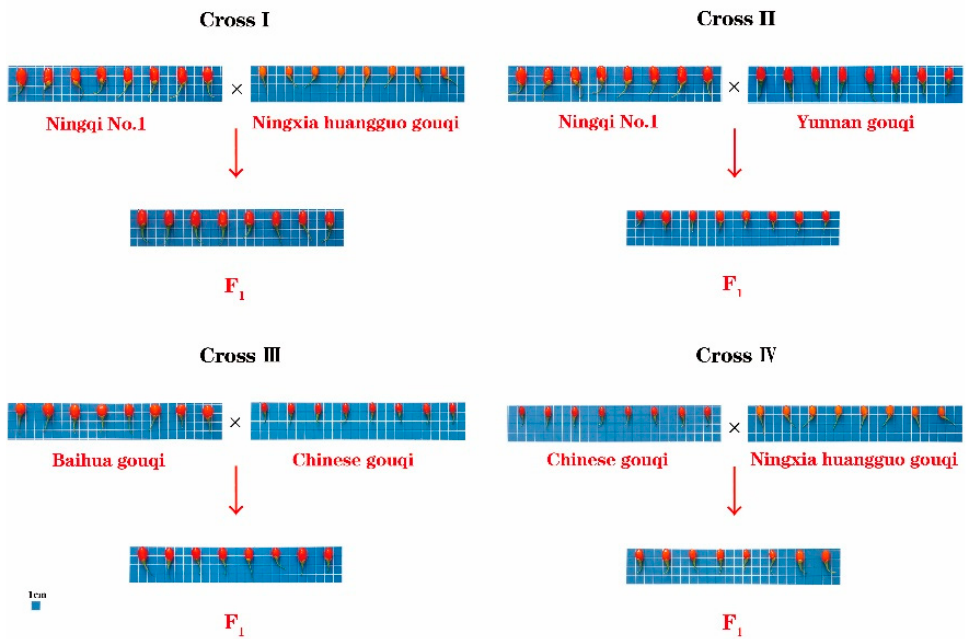
Figure 1. Fruit morphology of four hybrid parents.